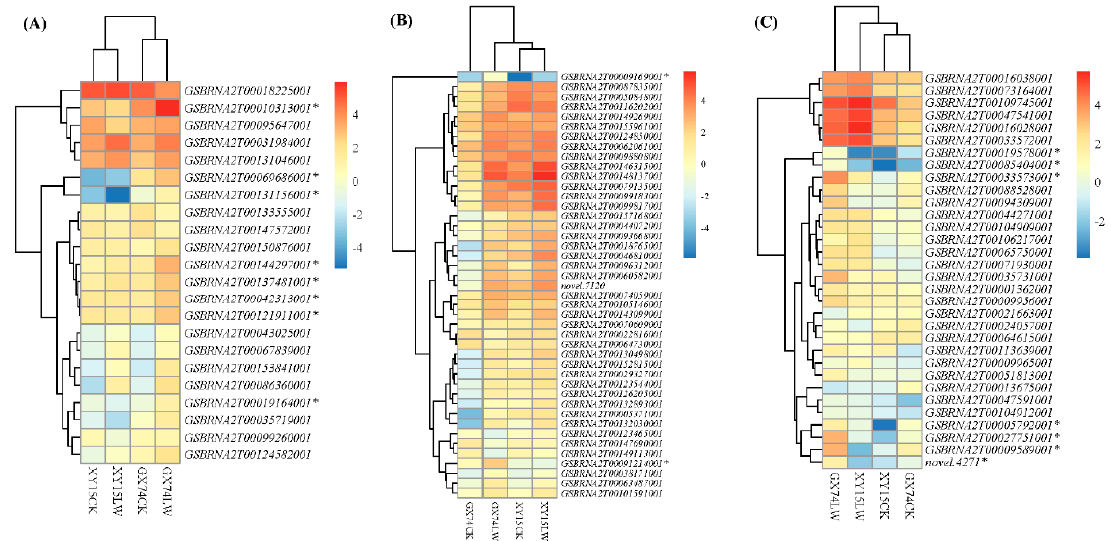
Figure 8. Heatmap of major transcription factors (family named on top of each heatmap) based on the log2-transformed mean value of fragments per kilobase of exon per million fragments mapped among the twelve samples (2 contrasting genotypes (XY15 and GX74) × 2 conditions (before cold treatment, CK; and cold treatment, LW) × 3 biological replicates, 1,2,3) mapped from rapeseed pods before and after cold stress. XY15 and GX74 are low-temperature-sensitive and -tolerant, respectively. ( A ). bZIP. ( B ). WRKY. ( C ). NAC. * Potential candidate genes responsible for the differential response in the two